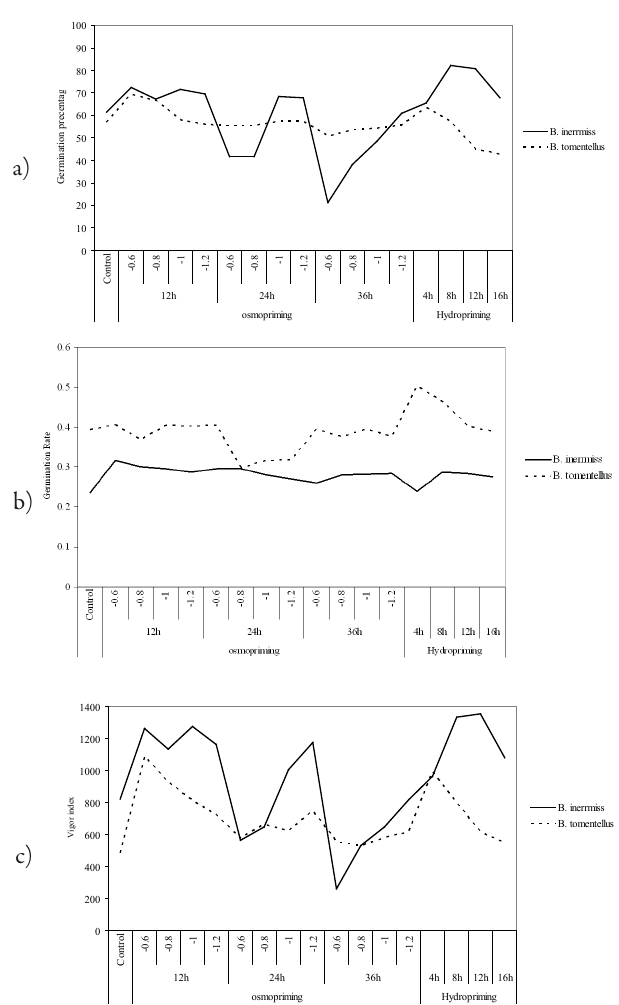
Fig. 1. Germination characteristics of two Bromus species un- der different priming treatments: a) Germination percentage; b) Germination rate; c) Vigour index (seedling length × germina- tion